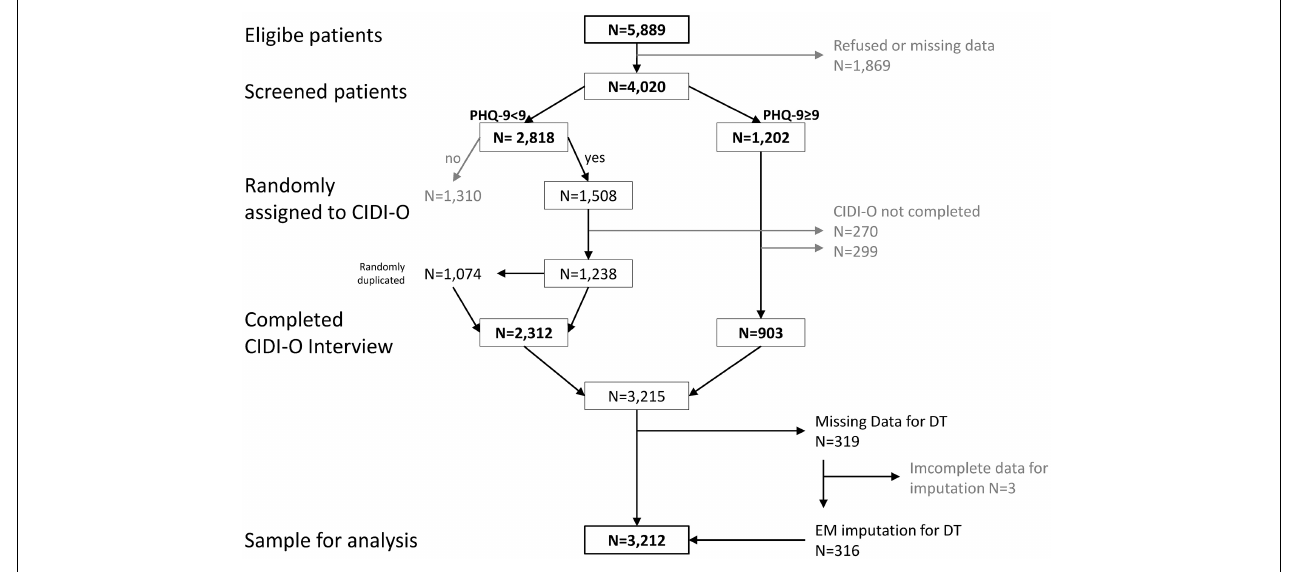
FIGURE 1 | Flowchart of the sample (patient recruitment, weighting,